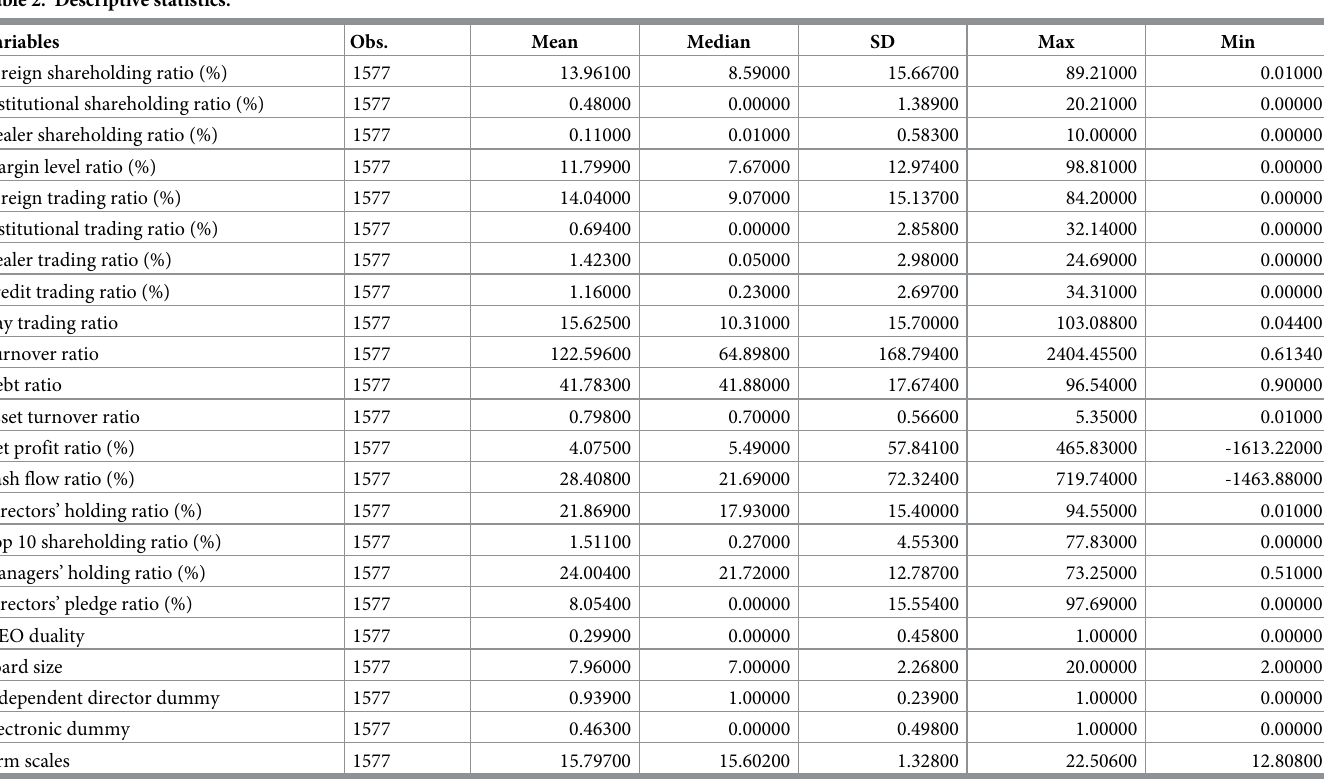
Table 2. Descriptive